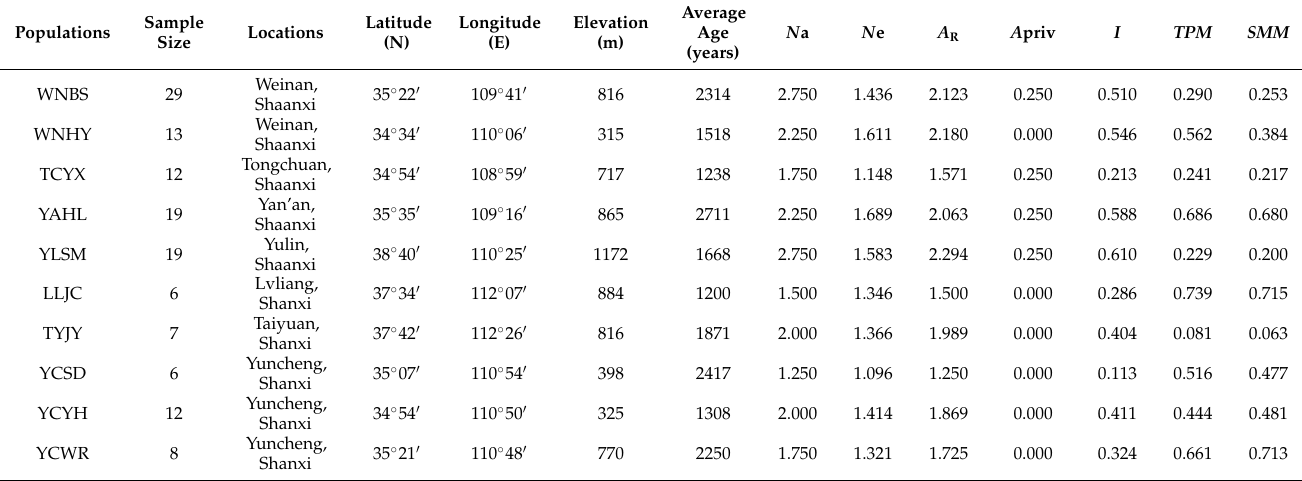
Figure 1. Geographical distribution of plant materials. Triangle points indicate the populations that were collected in the middle reaches of the Yellow River. The sector map shows the mean cluster membership proportions of the analyzed individuals in each of the 13 P. orientalis populations based on the structure at K = 2. Table 1. Geographical location and genetic variability statistics for 13 ancient P. orientalis populations in the middle reaches of the Yellow River.